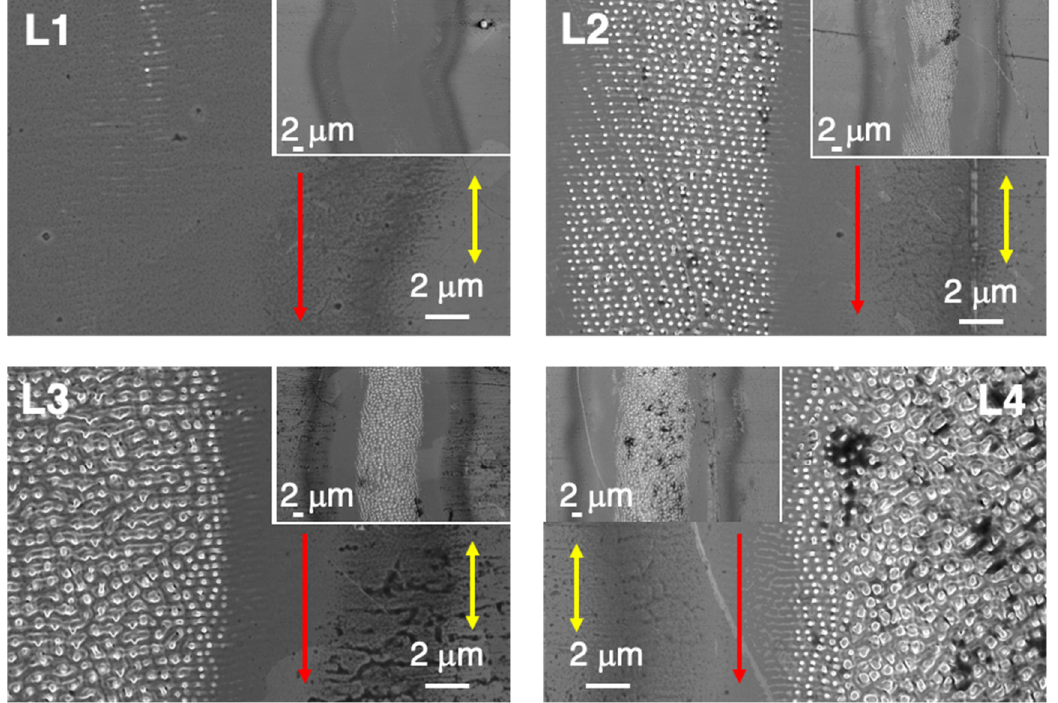
Figure 4. Top-view SEM micrographs (in-lens detector) of nanostructures generated on Ni5W tape in four vertical laser-processed lines obtained by combinations of two values of F av and v L indicated in Table 1. The insets show the aspect of the complete line section. Red (single) arrows indicate the scanning direction, while the yellow (double) ones indicate the corresponding orientation of the linear laser beam polarization. Table 1. 1D (line) laser processing parameters of the samples presented in Figure 4. The laser was operated at f rep = 800 kHz.